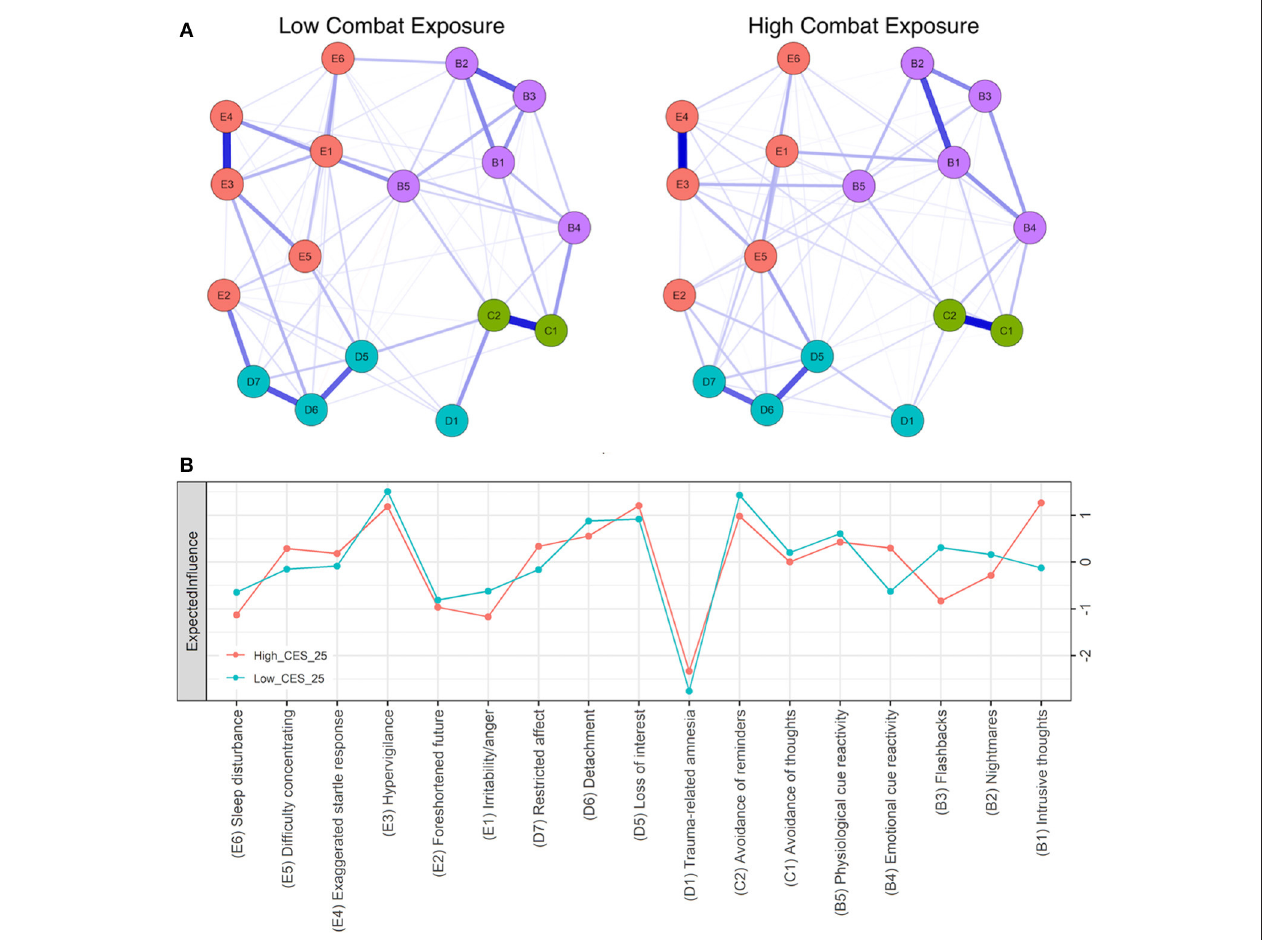
FIGURE 2 | (A) Seventeen-node DSM-IV PTSD symptom network comparison for low (left) and high (right) combat exposure groups. Blue lines represent positive associations, red lines negative ones, while the width and brightness of an edge indicate association strength. E1:B1 is significantly stronger in high combat exposure. Both networks are set to the same maximum edge (0.55) for comparison (B) Individual node strength values shown as standardized z-scores for high (CES > 25, orange) vs. low (CES < 25, blue) combat